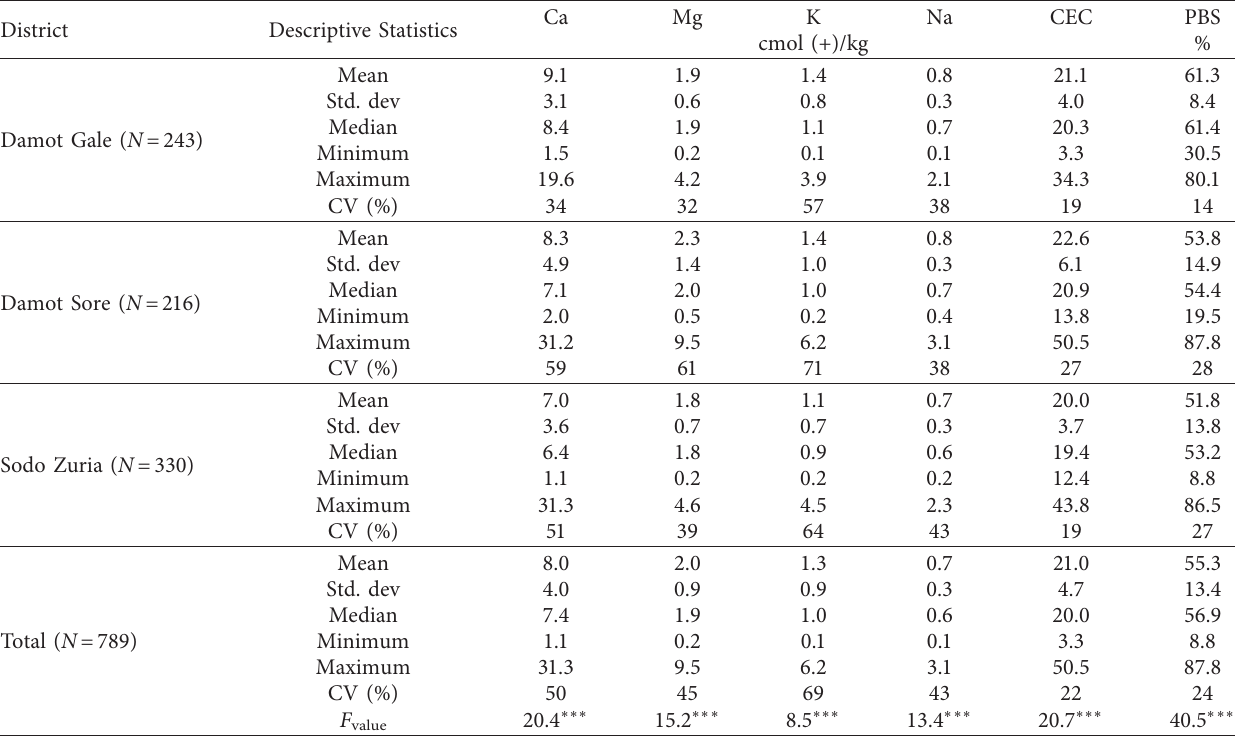
Table 6: Descriptive statistics of soil exchangeable bases, CEC, and PBS for surface soil.